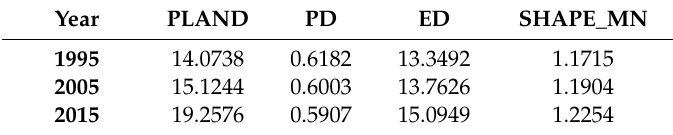
Table 5. Spatial metrics values of built-up land for 1995, 2005, and